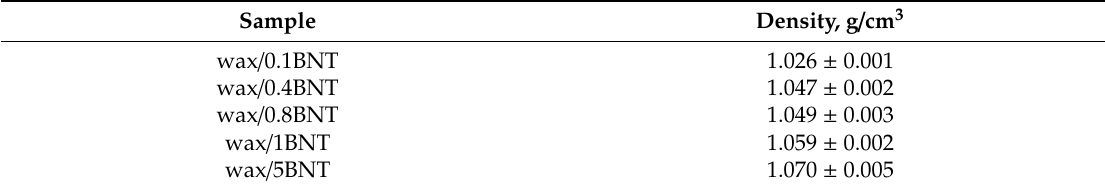
Table 5. Results of density measurements of PE-wax and its PE-wax / BNT